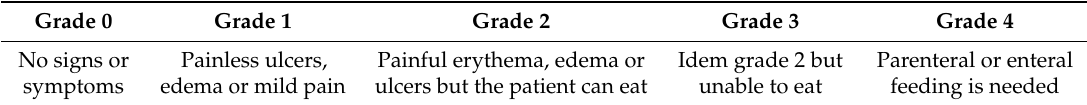
Table 1. Mucositis degrees according to WHO